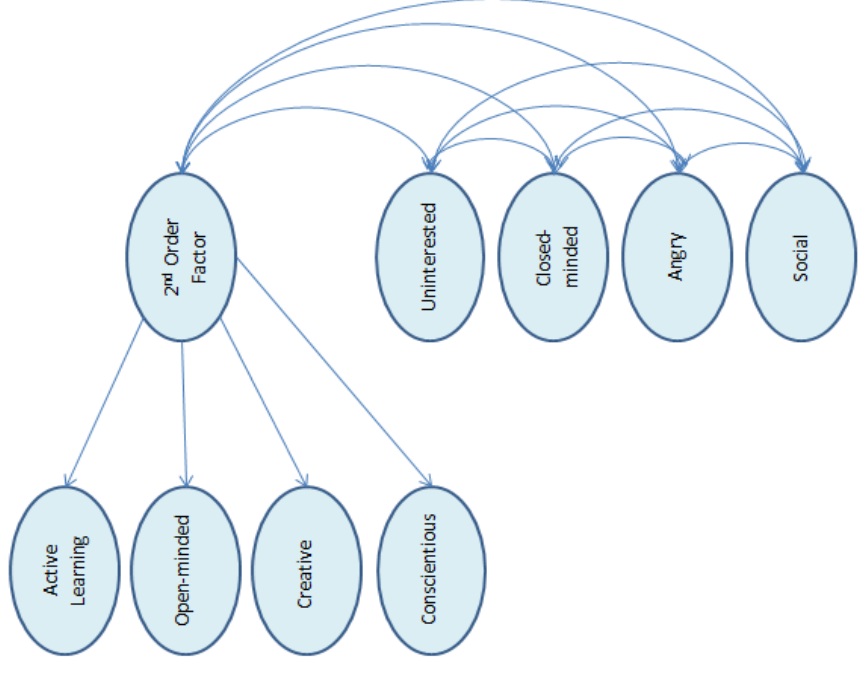
Figure 2. Second-Order Factor Model. Note: To simplify, items are listed in the appendix but are not shown in the